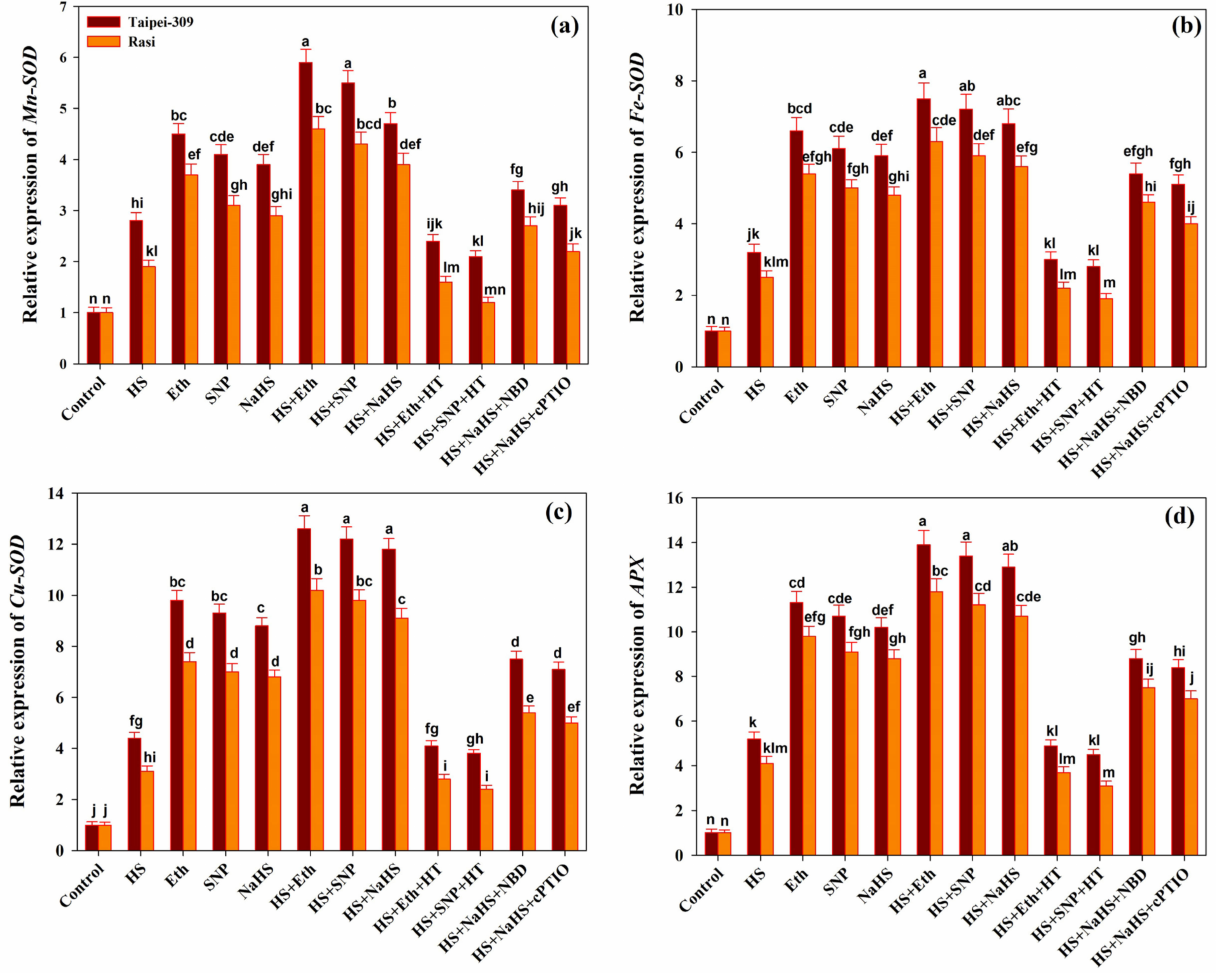
Figure 5. Relative expression of ( a ) Mn-SOD , ( b ) Fe-SOD , ( c ) Cu-SOD , and ( d ) APX of rice ( Oryza sativa L.) cultivars Taipei-309 and Rasi under control and high temperature stress (HS) supplied with 200 µ L L − 1 ethephon (Eth), 100 µ M sodium nitroprusside (SNP), 200 µ M sodium hydrosulfide (NaHS) or 100 µ M hypotaurine (HT), 100 µ M 2-4-carboxyphenyl-4,4,5,5-tetramethylimidazoline-1- oxyl-3-oxide (cPTIO), or 100 µ M norbornadiene (NBD) scavengers of hydrogen sulfide (H 2 S), nitric oxide (NO), and ethylene action inhibitors, respectively. Data are presented as treatments mean ± SE ( n = 4). The values followed by the same letters did not differ significantly by LSD test at p <